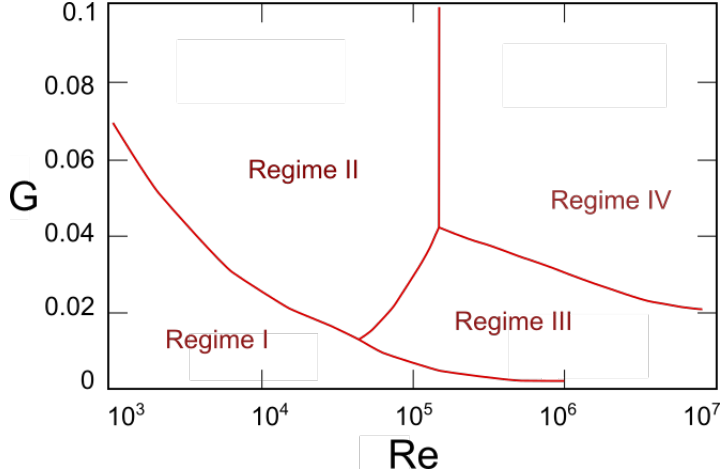
Figure 4. Map of regimes. Adapted with permission from [17], MDPI,